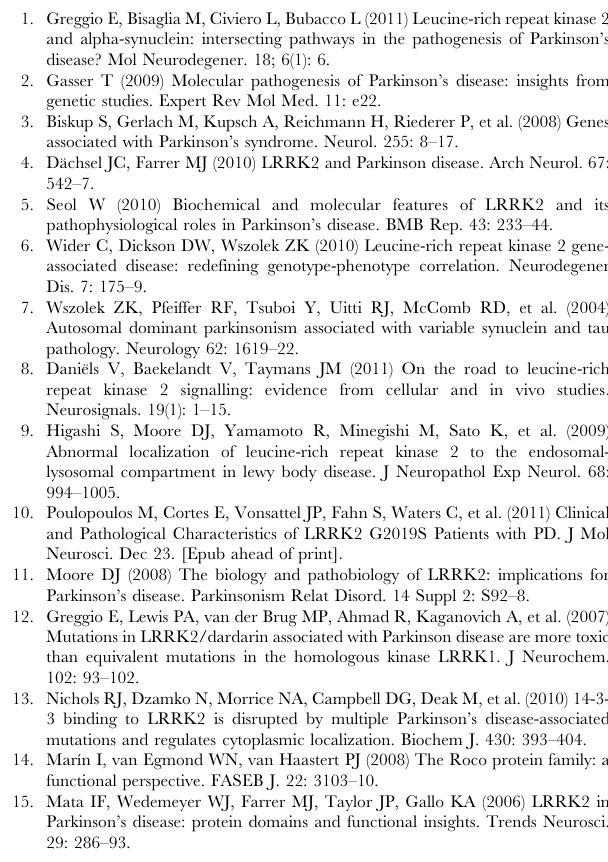
Table S3 Summary of statistical data for figure 2F. Data of Figure 2F were analyzed by one-way ANOVA with Bonferroni post hoc test for multiple comparisons. Table S4 Summary of statistical data for figure 3. Data of Figure 3B were analyzed by one-way ANOVA with Bonferroni post hoc test for multiple comparisons. Table S5 Summary of statistical data for figure 4. Data of Figure 4B were analyzed by one-way ANOVA with Bonferroni post hoc test for multiple comparisons. Table S6 Summary of statistical data for figure 5. Data of Figure 5 were analyzed by one-way ANOVA with Bonferroni post hoc test for multiple comparisons. Table S7 Summary of statistical data for figure 6. Data of Figure 6B were analyzed by one-way ANOVA with Bonferroni post hoc test for multiple